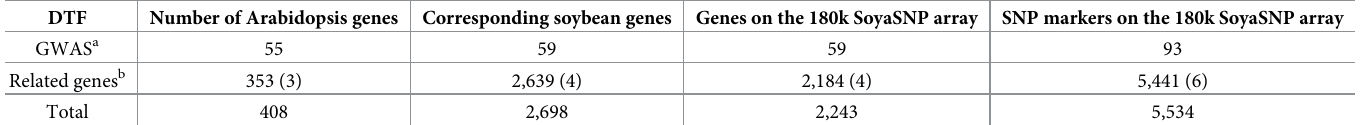
a Significant genes related to DTF derived from GWAS b Non-significant genes related to DTF and maturity in Arabidopsis . Values in parenthesis indicate the number of genes that overlapped with significant genes in